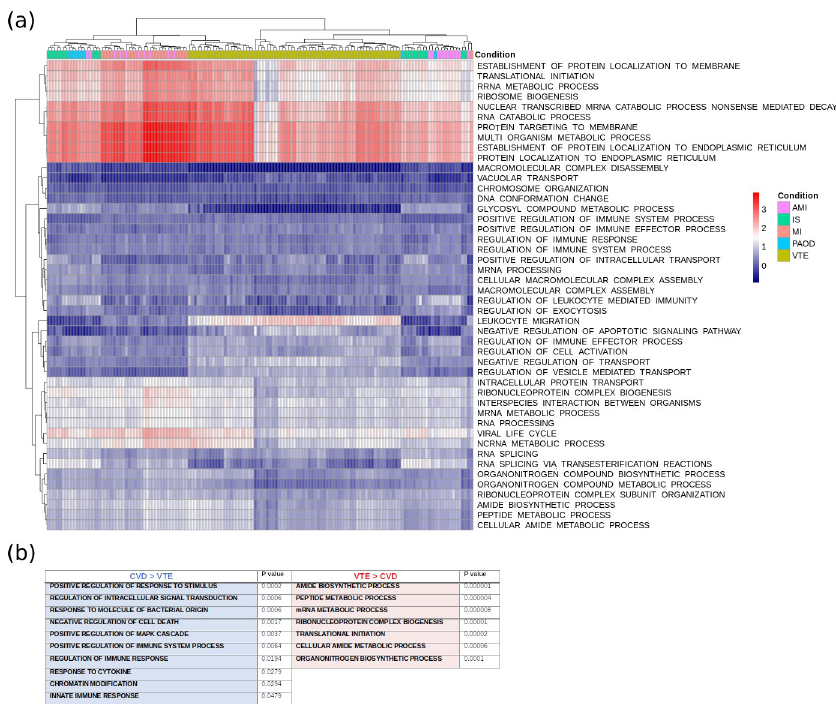
Fig 4. Heatmap (a) depicting FAIME scores of gene ontology (GO) terms enriched between VTE and CVD. FAIME scores compare the contribution of genes in different Gene Ontology pathways. Patients were segregated into VTE and CVD clusters based on their gene pattern similarities. The most significant terms were selected based on FDR ( < 0.05) and are summarized in the lower panel (b). VTE: venous thromboembolism; CVD: cardiovascular disease.